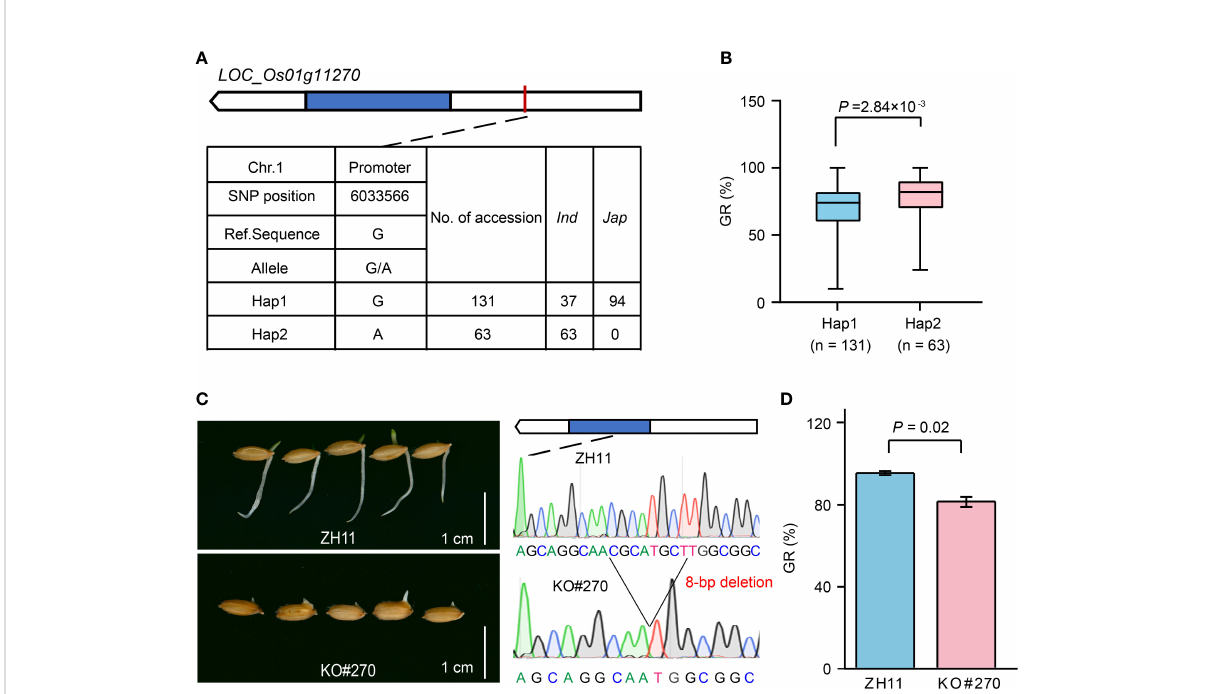
FIGURE 5 Effect of LOC_Os01g11270 on rice seed germination. (A) The top two haplotypes of LOC_Os01g11270 in 346 rice accessions. The blue box represents the exon, the white box indicates 2-kb upstream region of the start codon or 1-kb downstream region of the stop codon, and the black line represents the intron. (B) Comparison of GR between accessions containing Hap1 and Hap2. (C) Comparison of seed germination status after imbibition for fi ve days between LOC_Os01g11270 gene-edited mutant (KO#270) and its wild-type ZH11. (D) Comparison of GR between KO#270 and ZH11. Data represent mean ± SD from three replicates. The p-value is obtained from the